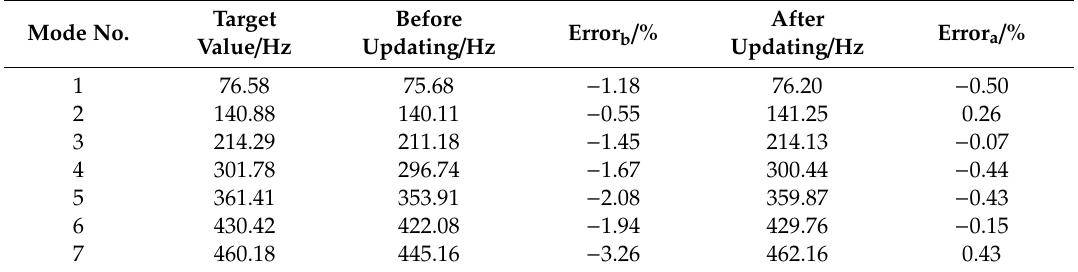
Table 3. Comparison of Frequency Values between FE Model and Target Model Under 5% White Noise.